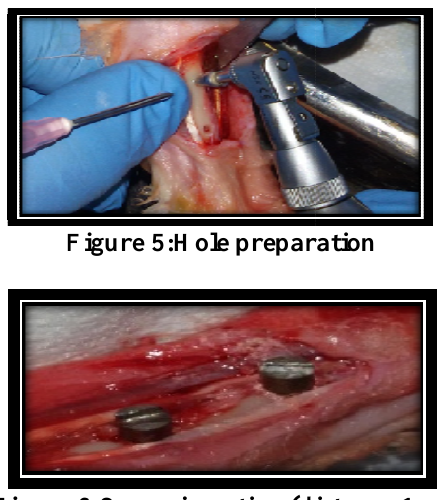
between 2 screws